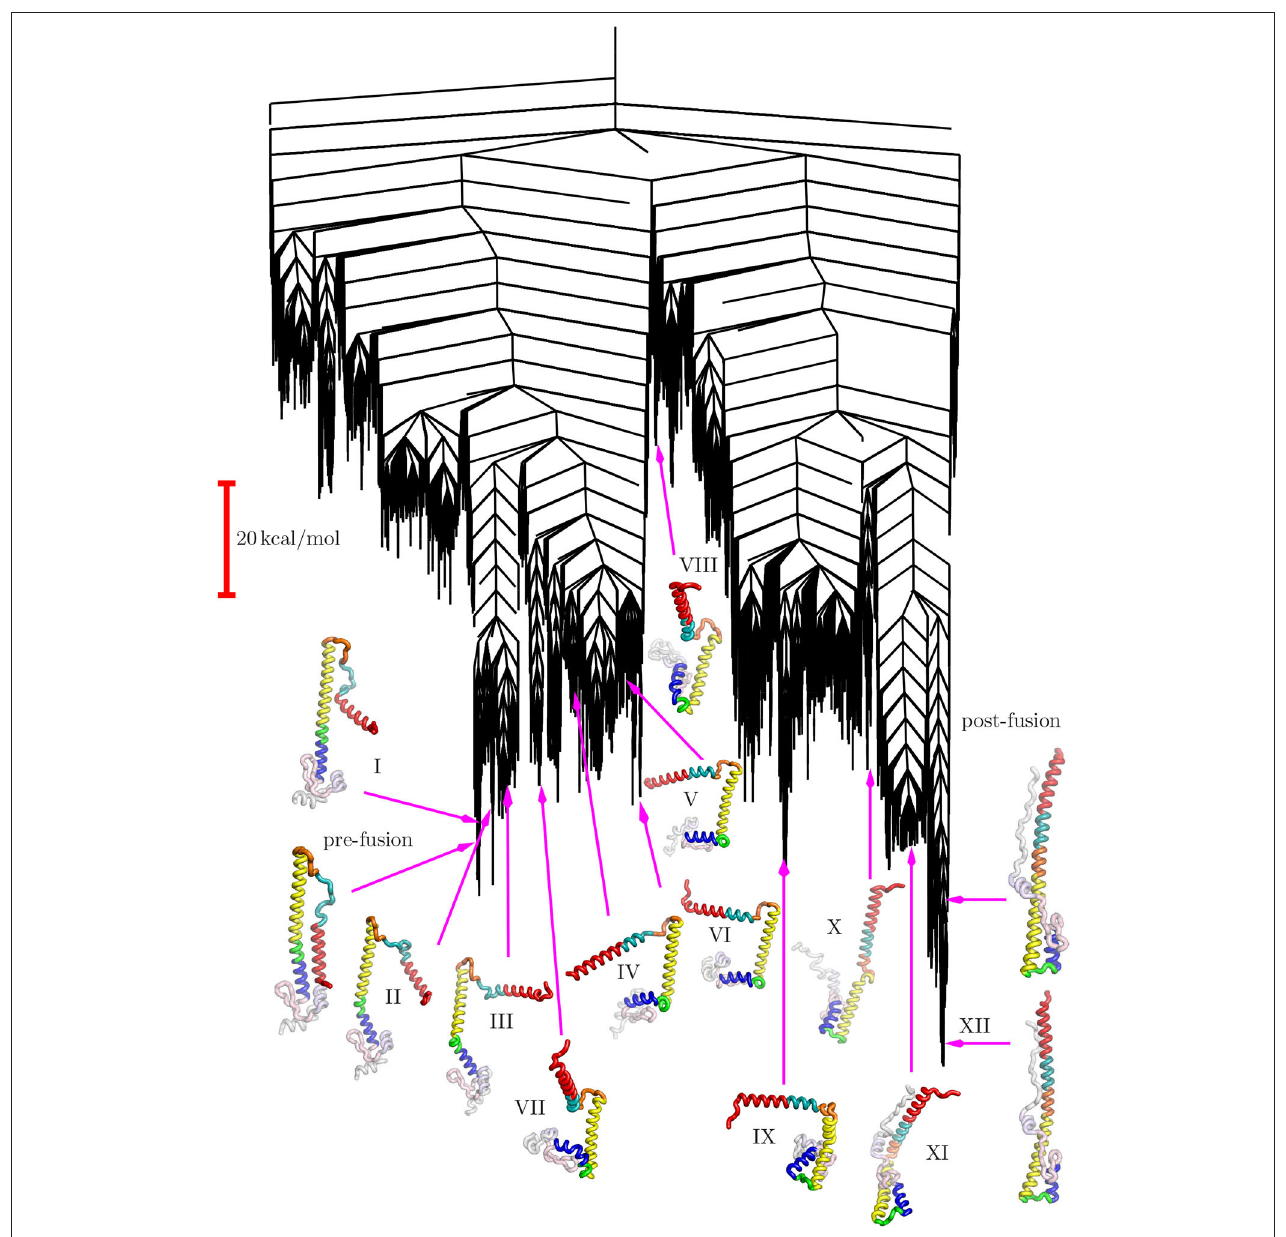
FIGURE 4 | Disconnectivity graph for the HA2 system marking the locations of the same selected minima from the pathway shown in Figure 3